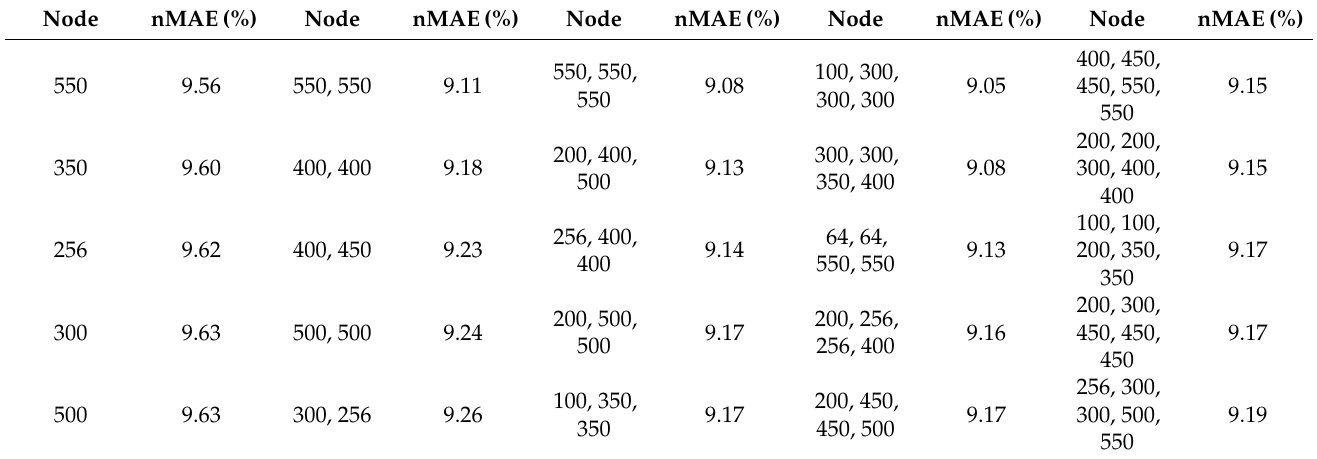
Table 6. Top 5 results of grid search by hidden layer configuration (17 months).